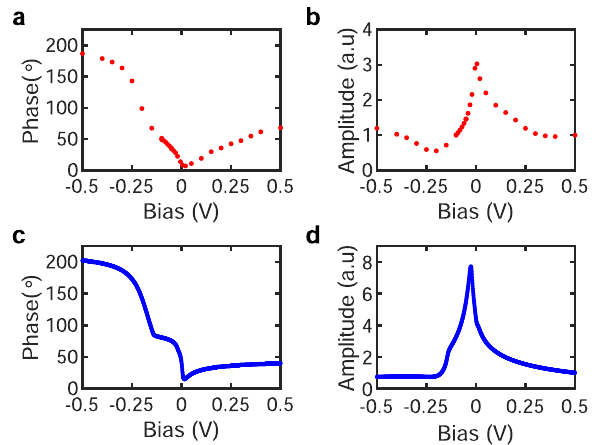
Fig. 3 Bias dependence of the phase and amplitude in experiments and in modelling. a and b show the bias dependence of the phase and amplitude of one of the unidirectional CDW extracted from the dephasing parameter and amplitude maps. c and d The phase and amplitude of the best matching simulations in the two-gap model. The data in b and d are normalized to their V b = 0.5 V